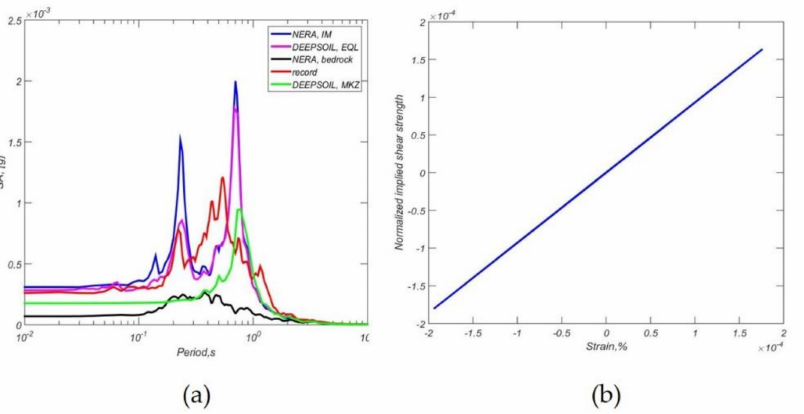
Figure 9. Modeling results for the Black Sea shelf site with soft clay layer of 14 m thickness: ( a ) response spectra SA(T, 5%) obtained by different modeling methods and real record; ( b ) stress–strain curves at the surface of the layer.